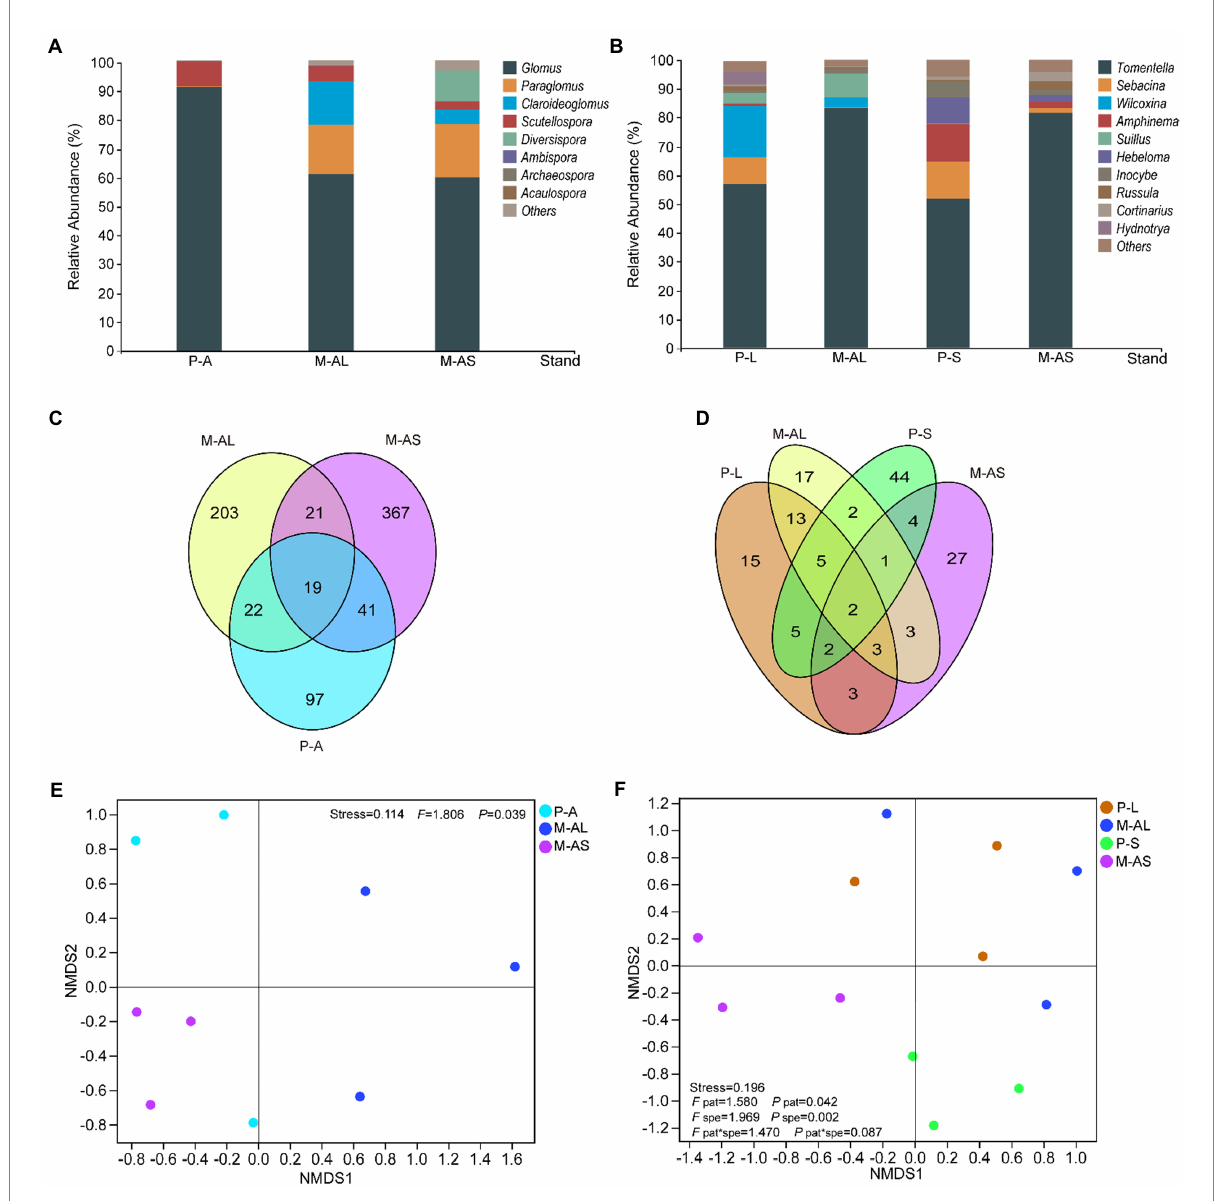
FIGURE 2 The relative abundance of genera of arbuscular mycorrhizal fungi (A) and ectomycorrhizal fungi (B) communities, venn diagram displaying the shared OTUs in arbuscular mycorrhizal fungi (C) and ectomycorrhizal fungi (D) communities as well as NMDS analysis of arbuscular mycorrhizal fungi (E) , ectomycorrhizal fungi (F) communities in rhizosphere soils of plantation stands at the Maoershan Experiment Station, Northeast China. P-A, Ash monoculture; M-AL, Ash-Larch mixture; M-AS, Ash-Spruce mixture; P-L, Larch monoculture; P-S, Spruce monoculture; pat, pattern; spe,